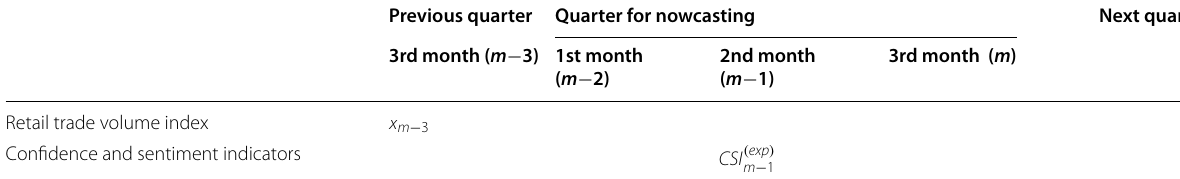
Table 2 Publication of information across time for private consumption on goods and services Previous quarter Quarter for nowcasting